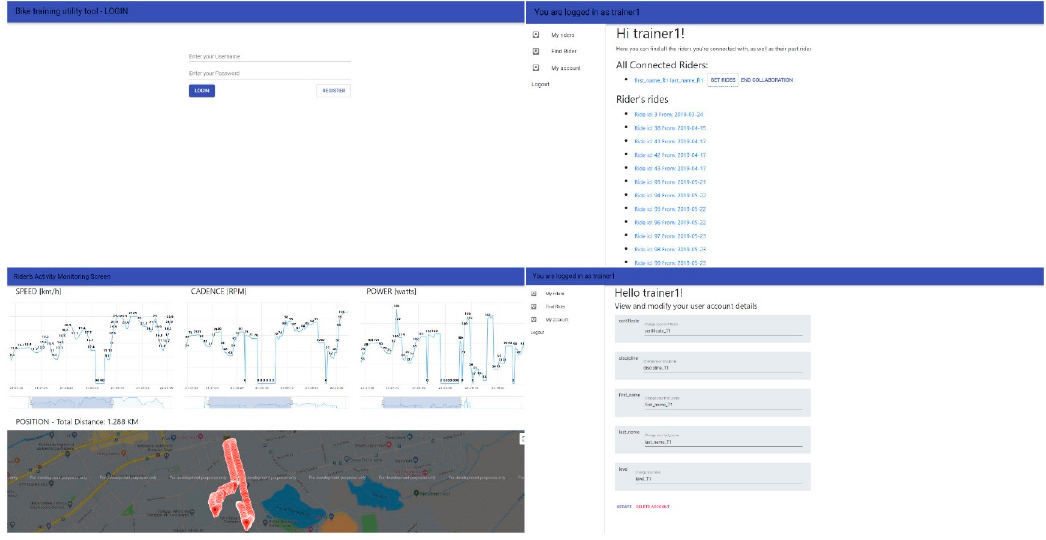
Figure 19. Web application of the Connected Bike